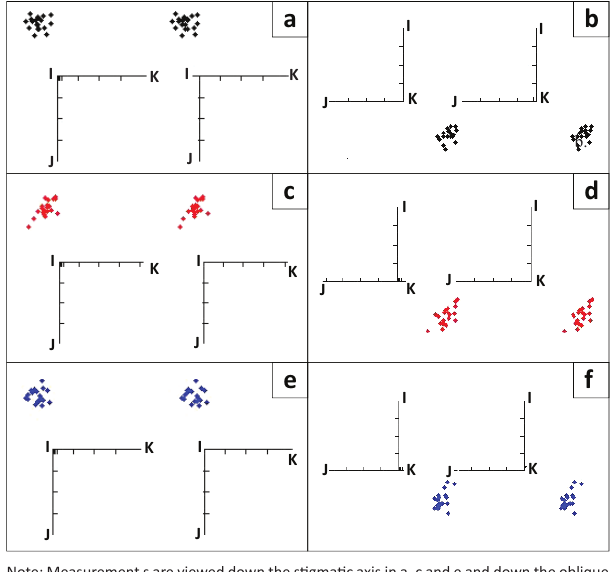
Note: Measurement s are viewed down the stigmatic axis in a, c and e and down the oblique antistigmatic axis in b, d and f. The stereo-pair scatter plot has an axis length of 1 D, origin is placed at 44 I D and the tick interval is 0.25 D. FIGURE 2: (a ‒ f) Rotated stereo-pair scatter plots for the anterior surface of the cornea. Each data point represents one of 20 Pentacam measurements taken at the first (black data points), second (red data points) and third (blue data points) measuring session.